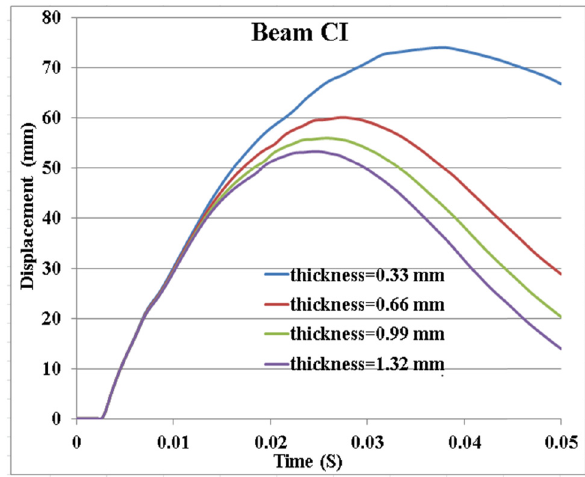
Figure 9: Displacement – time histories for various CFRP sheet thicknesses.